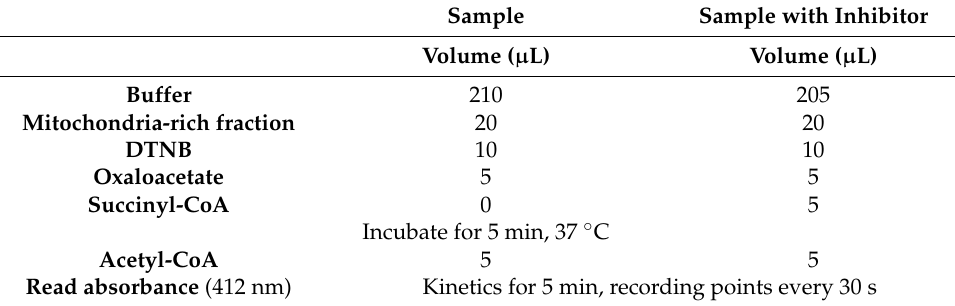
Figure 12. Reduction of DTNB with color change from colorless to yellow by the CoASH resulting from the condensation reaction of acetyl-CoA and oxaloacetate to form citrate promoted by CS. Table 10. Conditions and flow setup for CS activity assay.